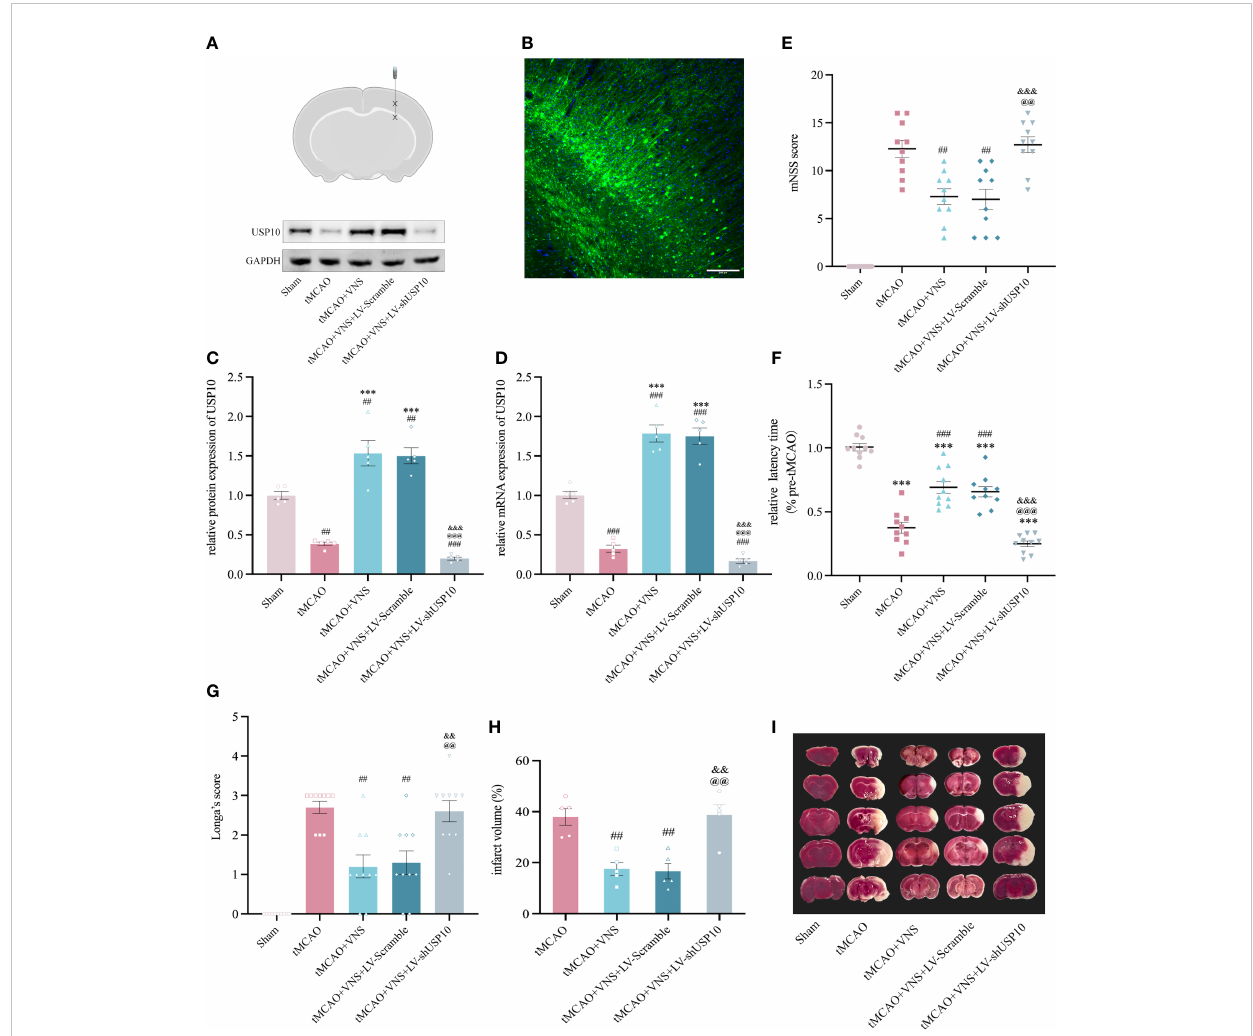
FIGURE 2 USP10 silencing suppressed the neuroprotective effect of VNS in mice with ischaemic stroke. (A) Schematic diagram of a mouse brain coronal section. Asterisk designates sites of lentiviral injection. (B) Distribution of lentiviral mediated gene transduction. The GFP fl uorescent protein in the vector can be expressed by the construct as a marker. The blue color shows the nuclei stained with DAPI. (C, D) USP10 expression in mice receiving LV-shUSP10 was assessed using western blotting (C, n=3) and RT-qPCR (D, n=5). (E – G) The neurobehavioral function was evaluated using mNSS Score (E) , and rotation test (F) Longa Score (G) . n=10. (H) Quantitative evaluation of brain infarct volume. n=5. (I) TTC staining images (white: infarct area; red: non-infarct). Data are mean ± SEM. ***P<0.001 vs. the Sham group; ###P<0.001 and ##P<0.01 vs. the tMCAO group. @@@P<0.001